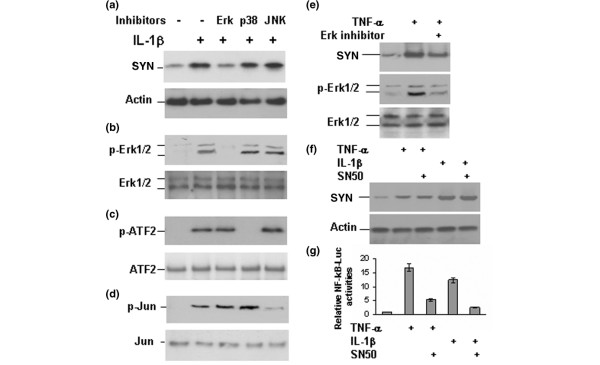
Interleukin (IL)-1β and tumor necrosis factor-α (TNF-α) induce Synoviolin (SYN) expression via the Erk pathway. (a) Synovial fibroblasts were partially starved for 24 hours by cultivation of these cells with media that contain 0.5% fetal bovine serum and then cultured with 10 ng/ml of IL-1β. Cells were also treated with each of the MAPK inhibitors. The concentrations of each inhibitor used were as follows: Erk inhibitor PD98059, 20 μM; JNK inhibitor SP600125, 10 μM; p38 inhibitor SB202190, 10 μM; and NF-κB inhibitor SN50, 20 μM. The expression of SYN was examined by Western blotting (top panel). The protein level of actin was reprobed as a control (bottom panel). (b) The activation of Erk was analyzed by anti-p-Erk antibody (top panel). The same membrane was reprobed by anti-Erk antibody (bottom panel). (c) p38 activation was analyzed by anti-p-ATF2 antibody (top panel). The same membrane was reprobed by anti-ATF2 antibody (bottom panel). (d) JNK1 activation was analyzed with anti-phospho-Jun antibody (top panels). The total protein levels of c-Jun were examined using anti-Jun (bottom panels). (e) Mouse synovial fibroblasts were starved for 24 hours and then cultured with 10 ng/ml of TNF-α without or with Erk inhibitor. The expression of SYN was analyzed by Western blotting (top panel). The activation of Erk was determined by anti-phosphorylated Erk antibody (middle panel). The protein level of Erk was analyzed by anti-Erk antibody (bottom panel). (f) The effect of NF-κB inhibitor on SYN expression. Mouse synovial fibroblasts were transfected with NF-κB-luc reporter, which contains firefly luciferase gene under control of NF-κB. The control plasmid pRL-TK encoding renillar luciferase was also included to correct transfection efficiency. Transfected cells were starved and then cultivated in the presence of 10 ng/ml of IL-1β or TNF-α without or with SN50 for 24 hours. The expression of SYN in these cells was analyzed by Western blotting (top panel), and the same membrane was reprobed with anti-actin (middle panel). (g) Parallel prepared cell lysates from (f) were used for testing the NF-κB-driven luciferase activity (bottom panel). Error bars represent three different experiments (mean ± standard deviation). Erk, extracellular signal-regulated kinase; JNK, c-Jun N-terminal kinase; MAPK, mitogen-activated protein kinase; NF-κB, nuclear factor-kappa B.